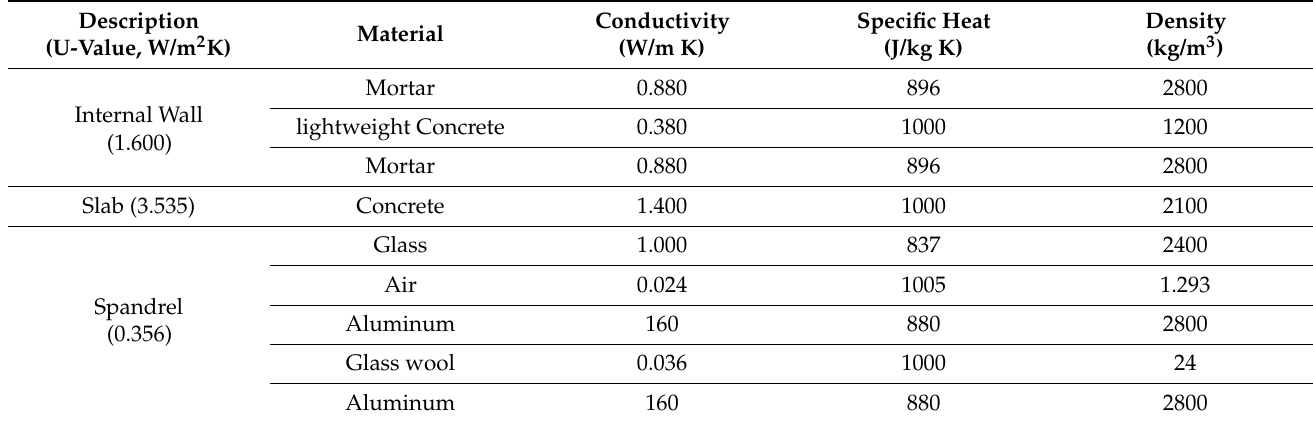
Table 2. Components and thermo-physical properties of materials [21].